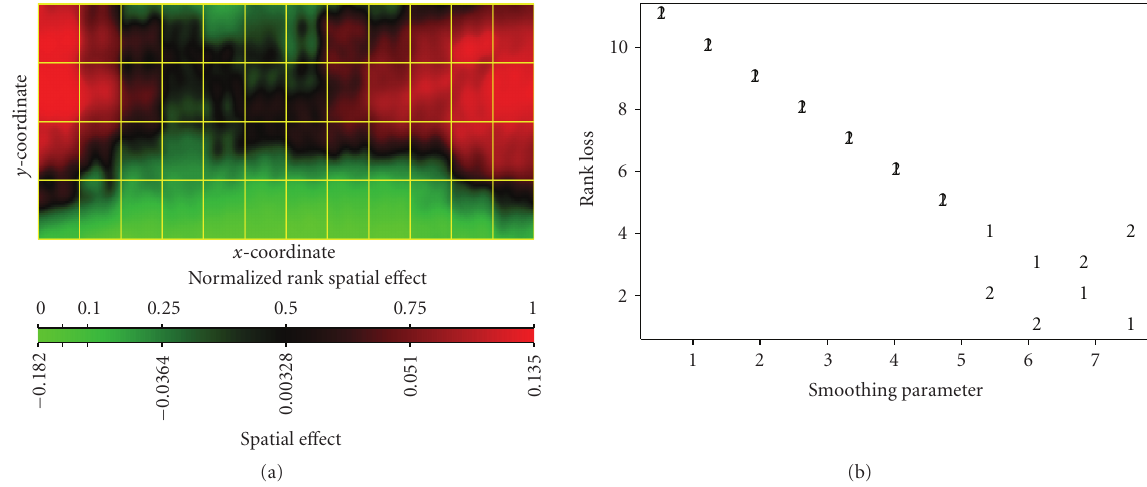
Figure 4: Spatial e ff ect: (a) the estimated spatial e ff ect as determined by a kernel density smoother. (b) The ranked cross-validation error as a function of the smoothing parameter (bandwidth) for the kernel density smoother. The cross-validation error is shown as an absolute error loss (“1”) and as a squared error loss